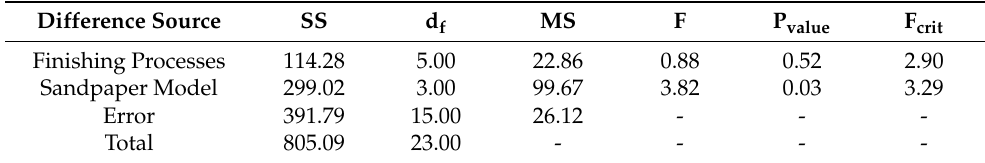
Table 15. Significance analysis of GZL.